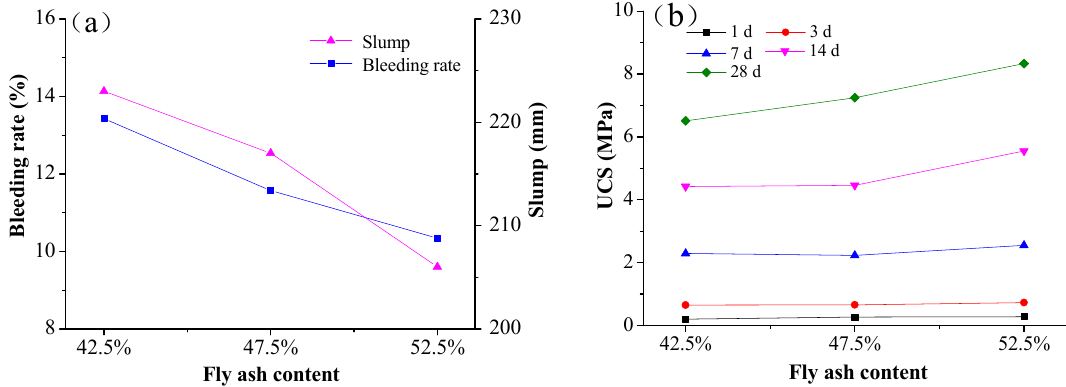
Figure 9. Effects of FA content on properties of filling material: ( a ) effects of FA content on transportation properties of filling material; ( b ) effects of FA content on mechanical properties of filling material.